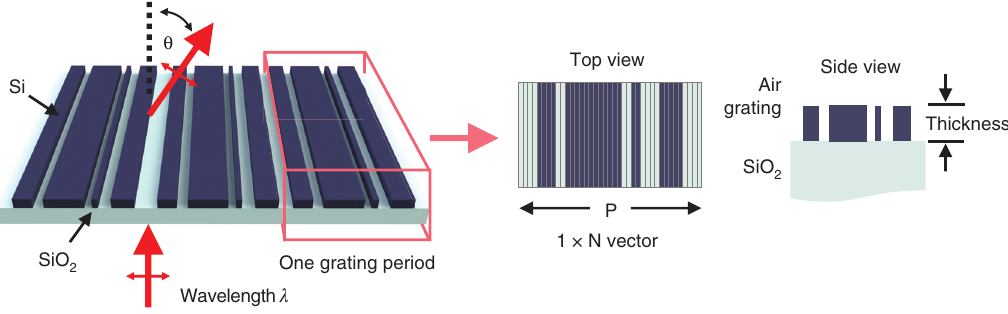
Figure 1: Schematic of a silicon metagrating that deflects normally incident TM-polarized light of wavelength λ to an outgoing angle θ . The optimization objective is to search for the metagrating pattern that maximizes deflection